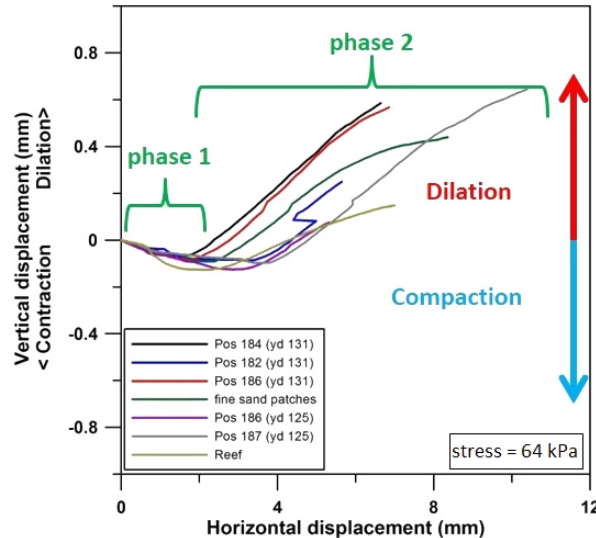
Figure 6. Horizontal displacement versus vertical displacement of samples with a grain size d ≤ 2mm measured in the small direct shear box under the highest normal stress. First a short phase of compaction was observed, before a strong dilation was monitored.